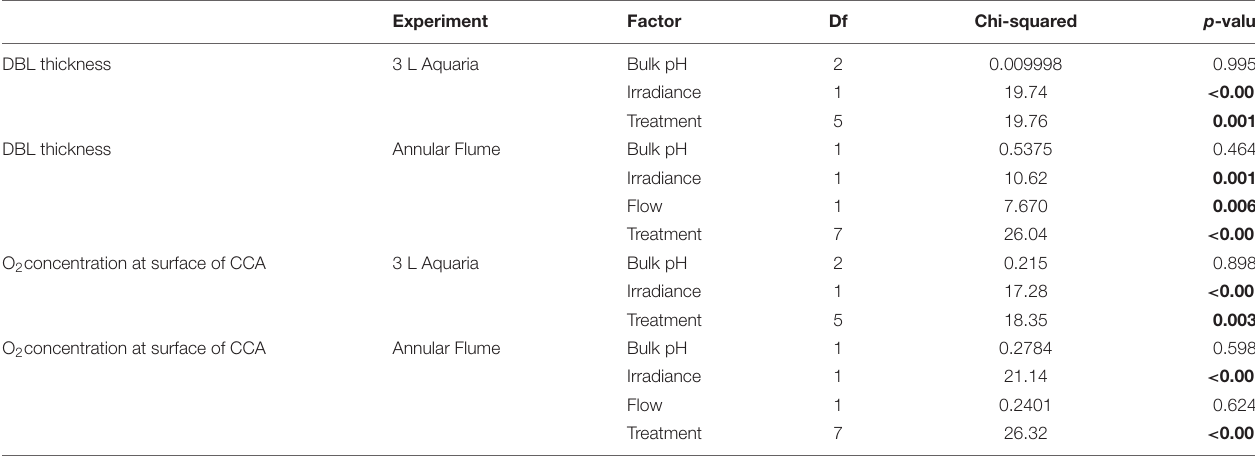
TABLE 3 | Non-parametric Kruskal–Wallis examining the effects of treatments, bulk pH, flow, and irradiance on DBL thickness and O 2 Concentration at surface of CCA in 3 L aquaria and the annular